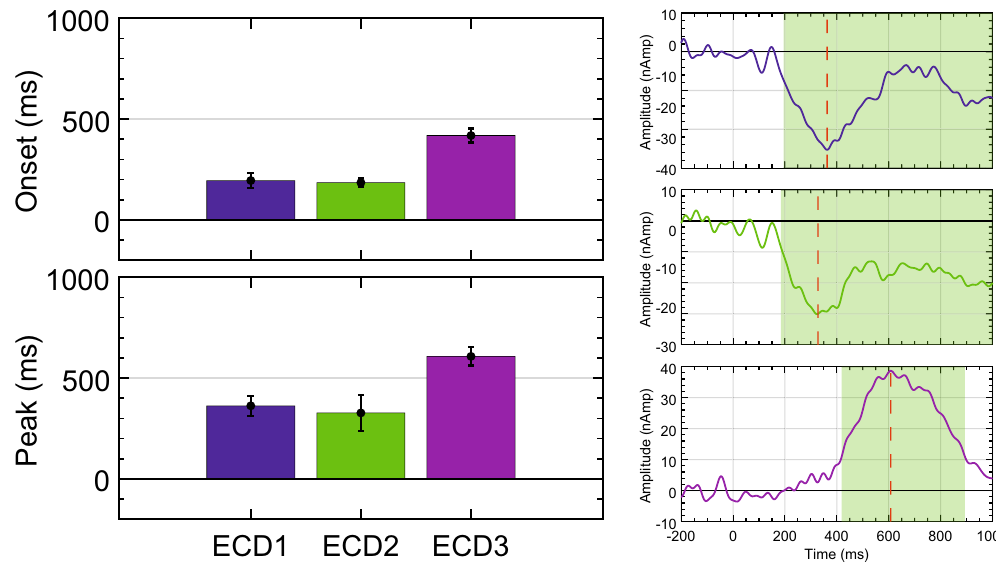
Figure 12. Mean latencies of source waveforms for Palumbo et al. 32 . Mean onset and peak latency for each ECD from Palumbo et al. 32 . Average source waveforms across all participants for each ECD are also shown. Component time-course using a 30% amplitude threshold is highlighted in green and peak latency is indicated by a red dotted